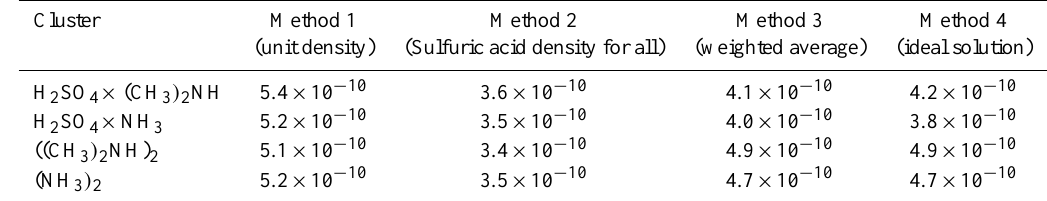
Table 1. Collision rate (units of 1s − 1 ) of sulfuric acid with base containing clusters for different methods of estimating the cluster